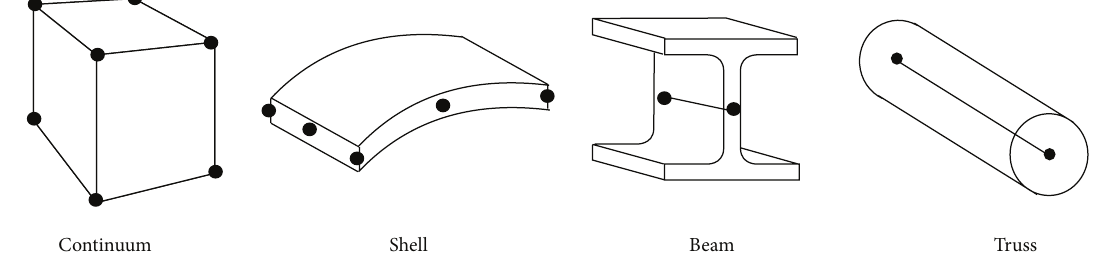
Figure 6: Some classical element types [35].